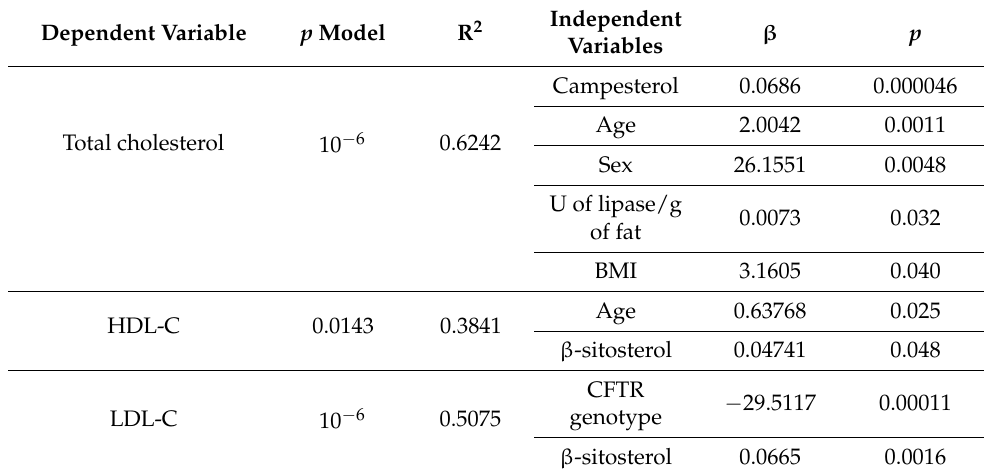
Table 5. Forward (total cholesterol and HDL) and backward (LDL) stepwise regression analyses of various factors predictive of cholesterol and its fractions in cystic fibrosis patients.